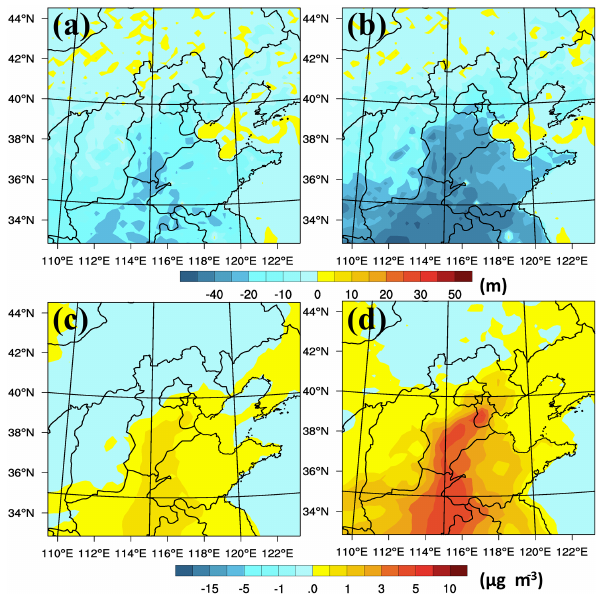
Figure 9. Monthly mean wind fields for WS20 case (a) and changes of wind speeds (CTL–CTL_WS20) (b) , and mean changes of PM 2 . 5 concentrations based on 1960 emission levels (c) and 2010 emission levels (d) .